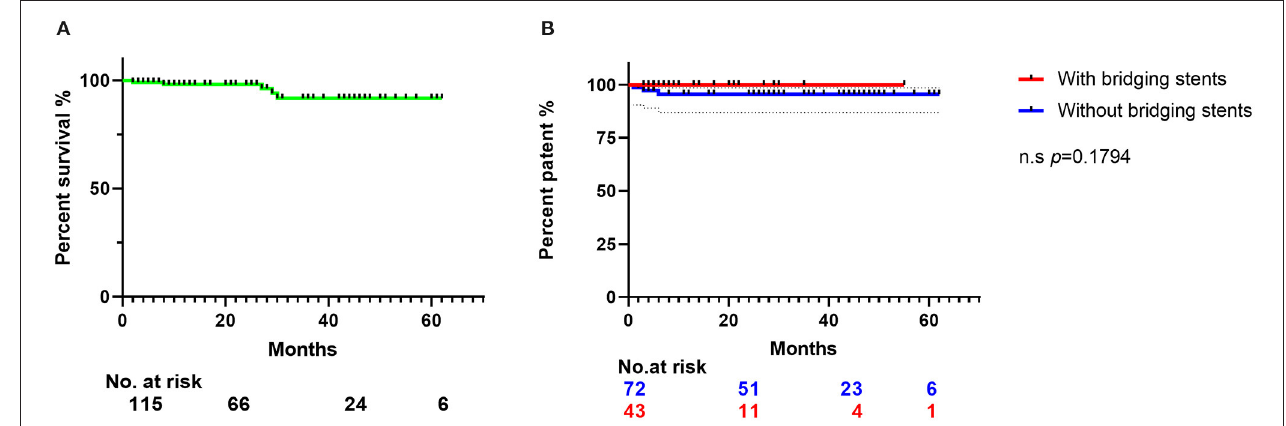
FIGURE 3 | The Kaplan–Meier curve shows the survival rates of the 115 patients’ follow-up data. (A) The Kaplan–Meier curve of the patients’ survival rates in 23 ± 18 months’ follow-up. (B) Patent rates of branch arteries preserved by fenestration. Blue line represents the SF-TEVAR without bridging stent, and red line represents the SF-TEVAR with bridging stent. There is no significant difference between the patent rate of two groups ( p = 0.1794). CTA, computed tomography angiography; LSA, left subclavian artery; SF, self-radiopaque physician-modified fenestration; TEVAR, thoracic endovascular aortic repair; PAU, penetrating aortic ulcer; LCA, left carotid artery.